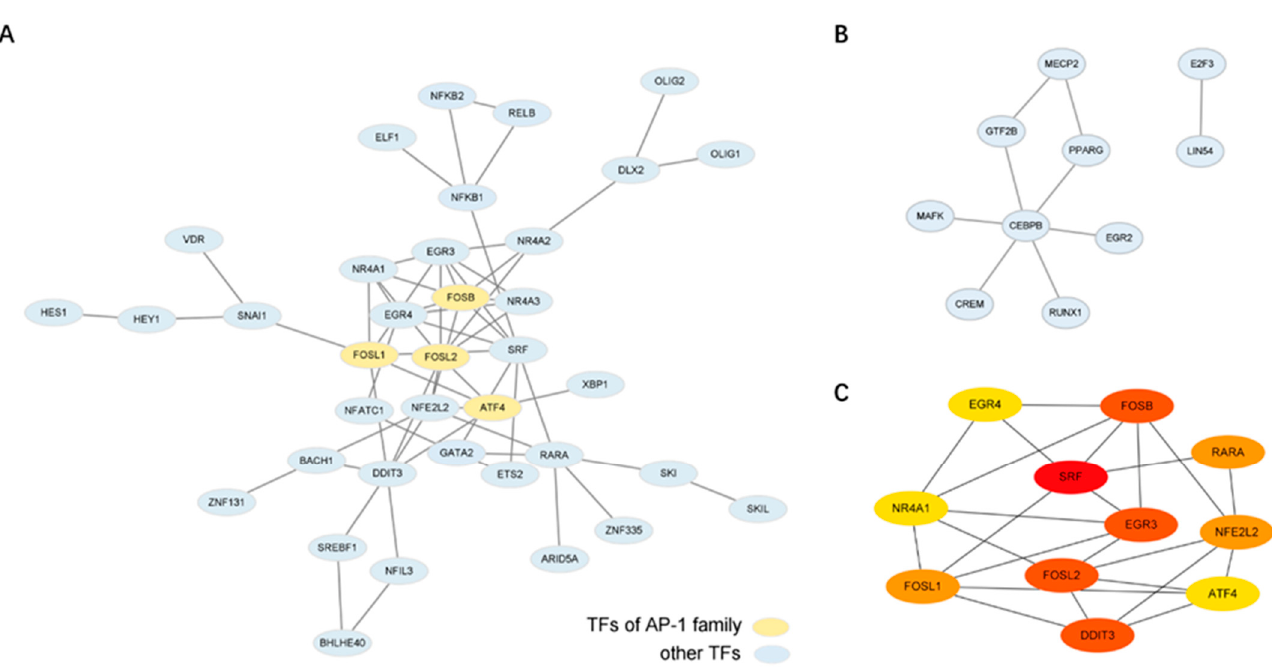
Figure 3. TFs that exhibit the enriched PPIs with other TFs in their group. ( A ) Up-regulated group 1 exhibits extensive PPIs. Colored in yellow are those TFs that are members of the AP-1 family (FOSB, FOSL1, FOSL2, and ATF4). ( B ) Up-regulated group 2 also exhibits a PPI network, primarily involving CEBPB. ( C ) A zoomed-in view of those genes of the up-regulated group 1 that exhibit the greatest number of connections.